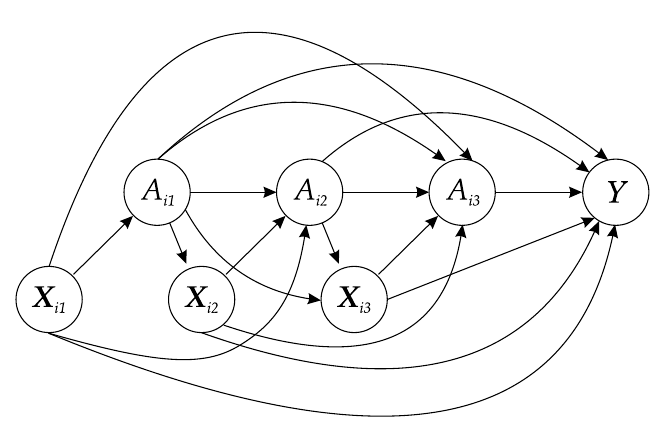
Figure 1: Data Generating Process in Simulation Study. posed method under different misspecifications of the treatment assignment model regarding lag structure, measurement error, distributional family and cross-time